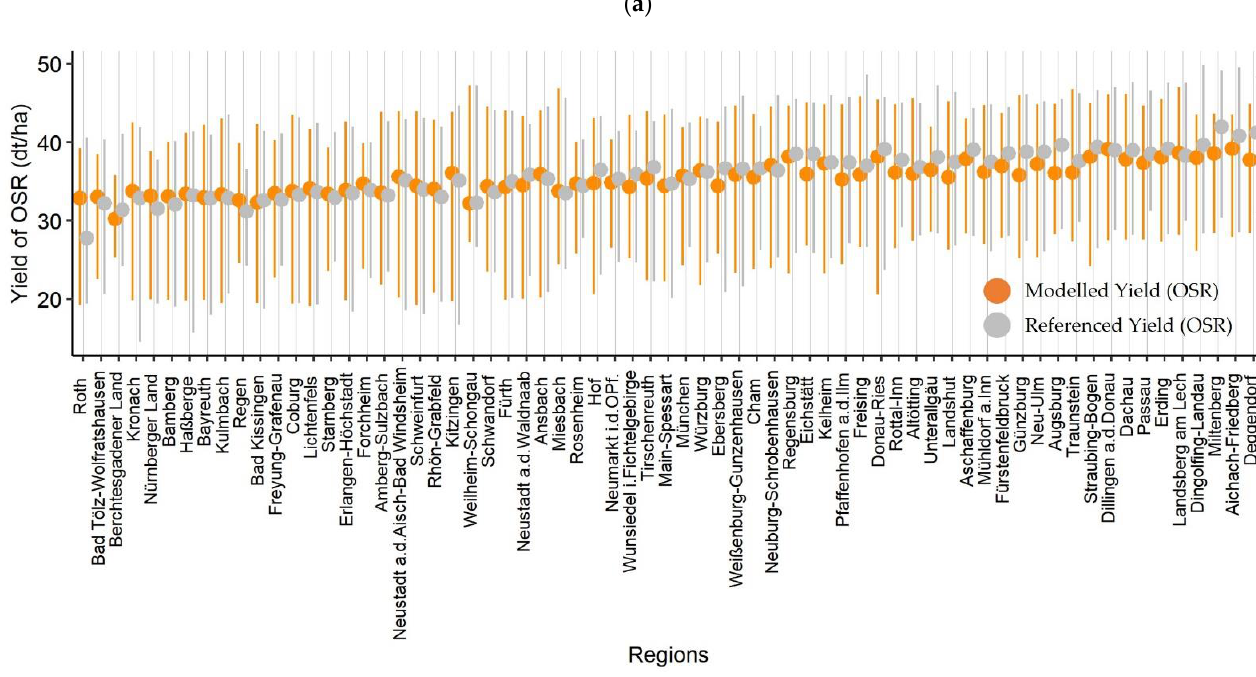
Figure 12. The dot plots show the district-wise distribution of modelled yield for ( a ) WW and ( b ) OSR, from 2001 to 2019. The green colour depicts the modelled yield of WW, the orange colour depicts the modelled yield of OSR, and the grey colour depicts both referenced yields of WW and OSR.